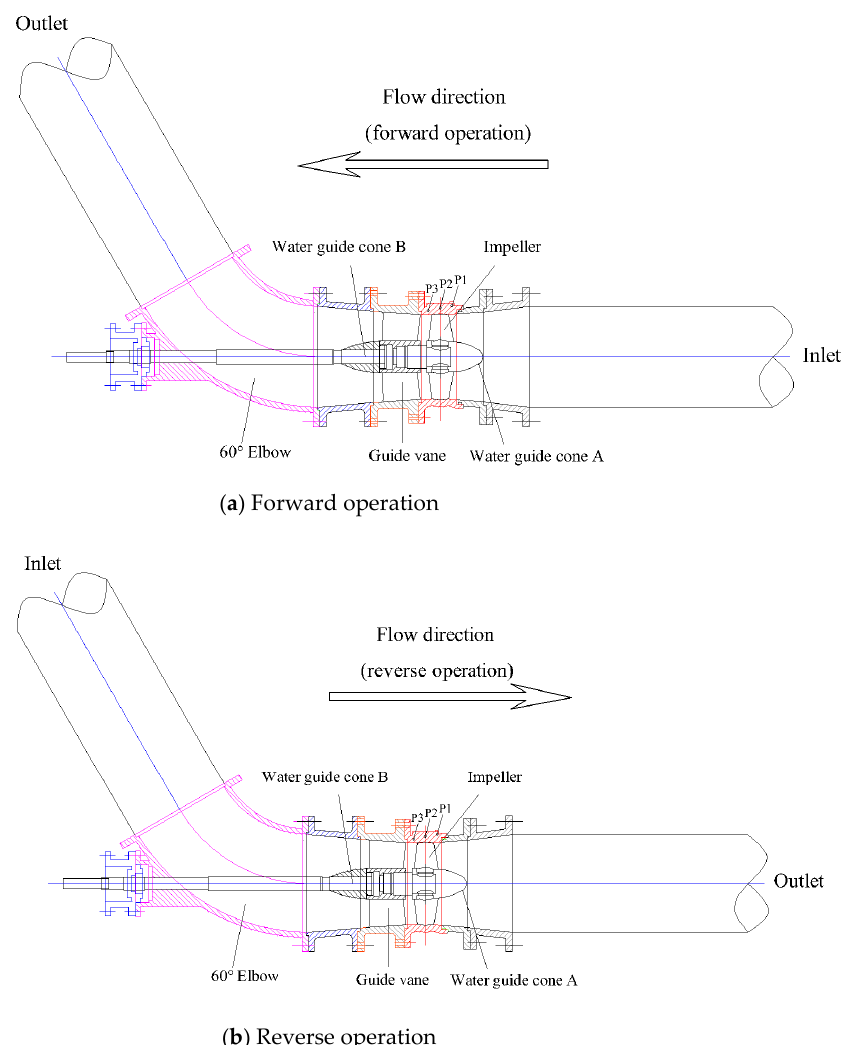
Figure 3. Schematic diagram of standard pump section in experiment.